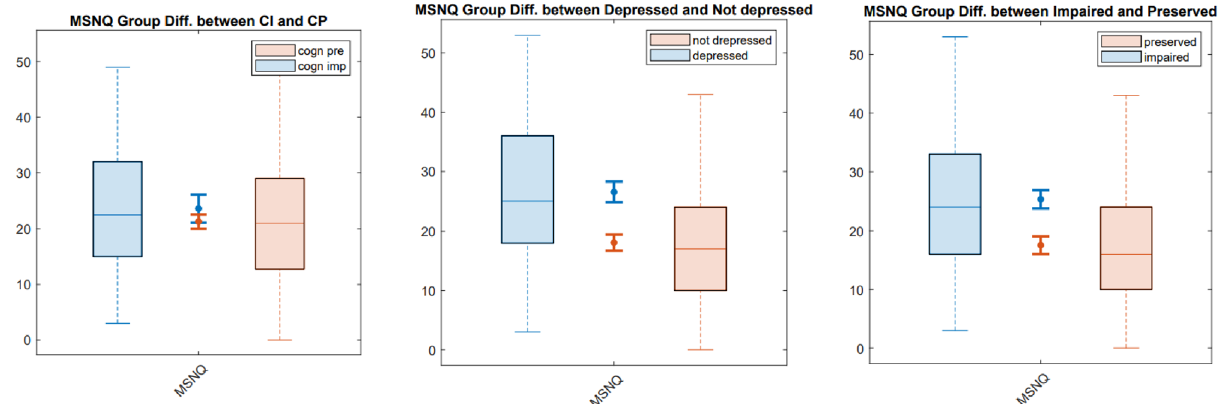
Figure 1. Group differences in MSNQ scores in cognitively impaired and depressed patients. Box plots of the MSNQ scores of cognitively impaired versus cognitively preserved patients (first panel), depressed versus non-depressed patients (second panel) and impaired (i.e. cognitive impairment and/or depression) versus non- impaired (i.e. no cognitive impairment or depression) patients (third panel). Diff. differences, MSNQ Multiple Sclerosis Neuropsychological Questionnaire, CI cognitively impaired, CP cognitively preserved, impaired depression and/or cognitive impairment, preserved no depression or cognitive